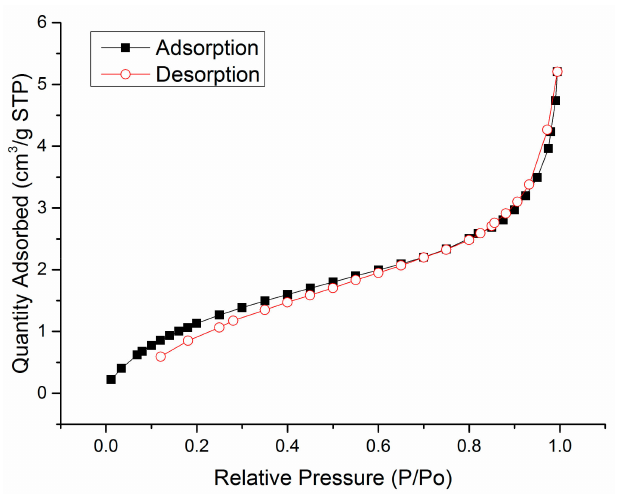
Figure 1. N 2 adsorption and desorption curves recorded for poplar catkin fibers.